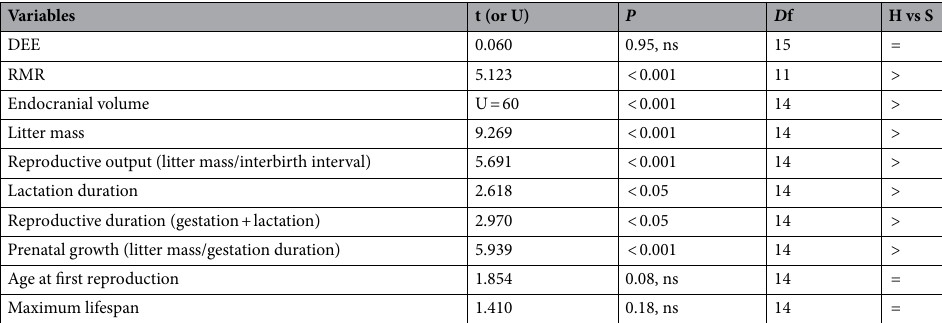
Table 3. Energy expenditure, brain size and life history compared between the haplorhines (H) and strepsirhines (S) selected after removing the effect of body mass. Data are species residuals extracted from the PGLS regression of each variable against body mass in a large sample of non-human primates (life history and brain size: n = 86 non human primate spp., DEE: n = 17 spp., RMR: n = 40 spp.). The last column indicates whether haplorhines have similar ( =) or higher ( >) values than strepsirhines. Note that comparisons do not change when including humans.